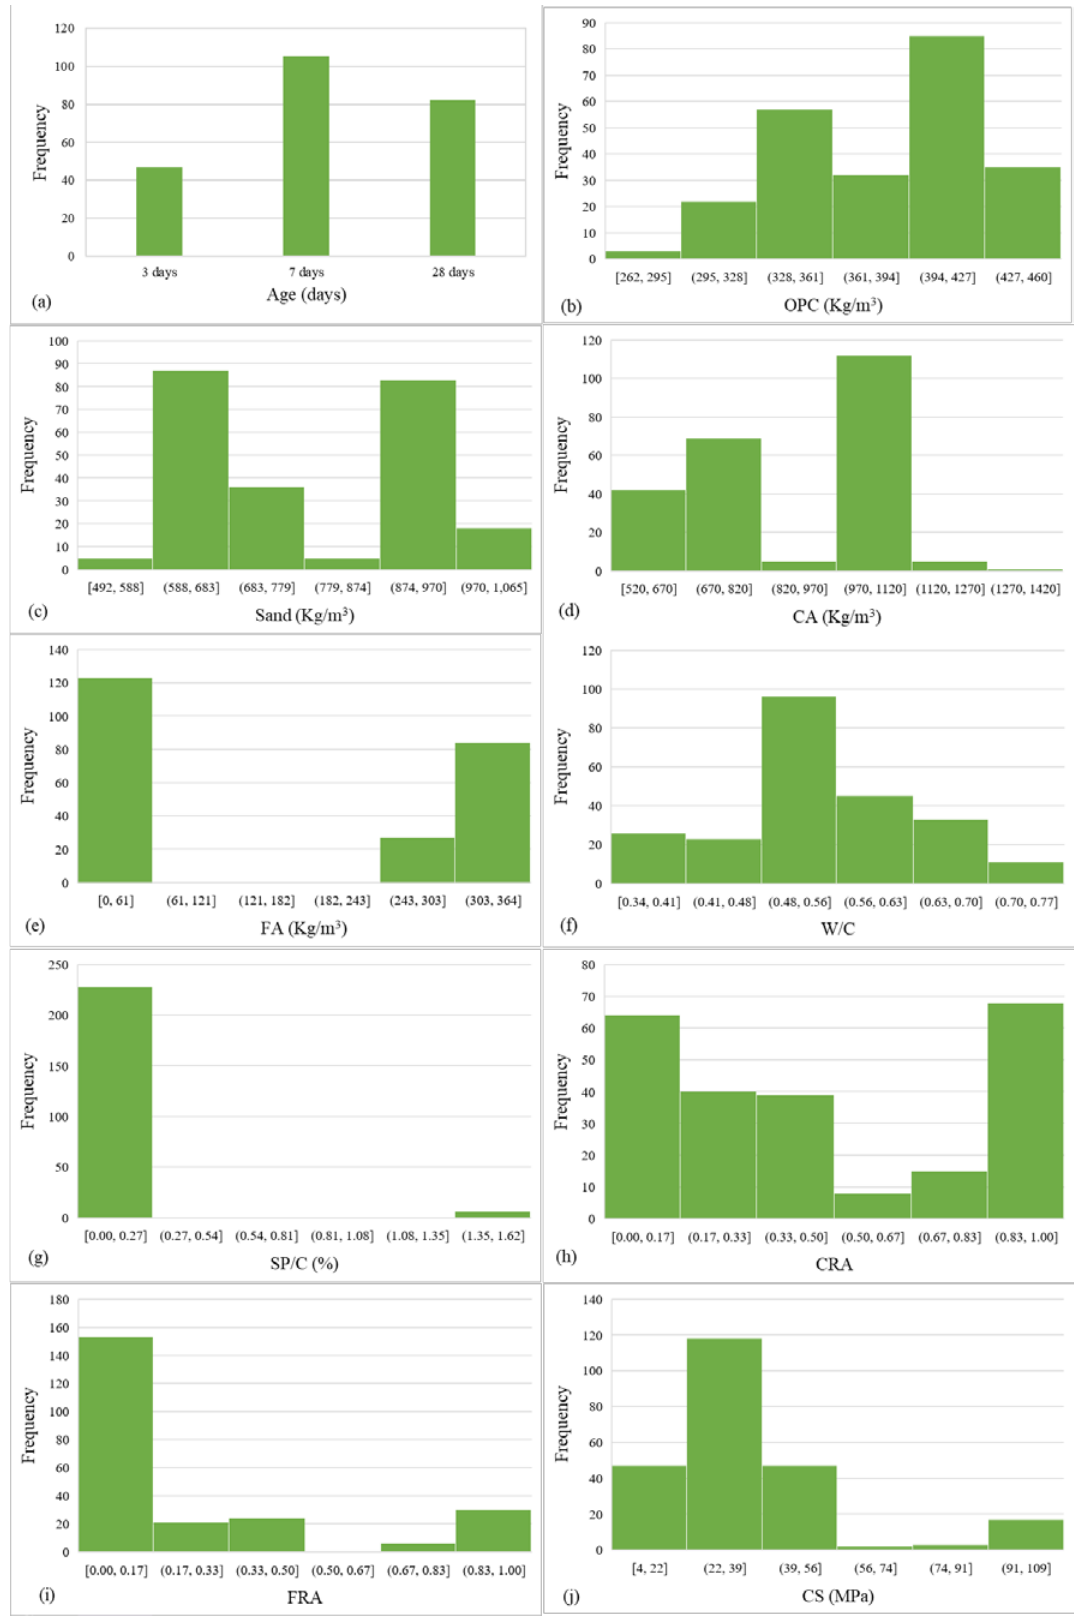
Figure 1. Output and input variables’ histogram: ( a ) ages of samples, ( b ) the amount of OPC, ( c ) the amount of sand, ( d ) the amount of coarse aggregate, ( e ) the amount of fine aggregate, ( f) the ratio of water to cement, ( g ) the ratio of super- plasticizer to cement by percentage, ( h ) the ratio of recycled coarse aggregate to total coarse aggregate, ( i ) the ratio of recycled fine aggregate to total fine aggregate, and ( j ) compressive